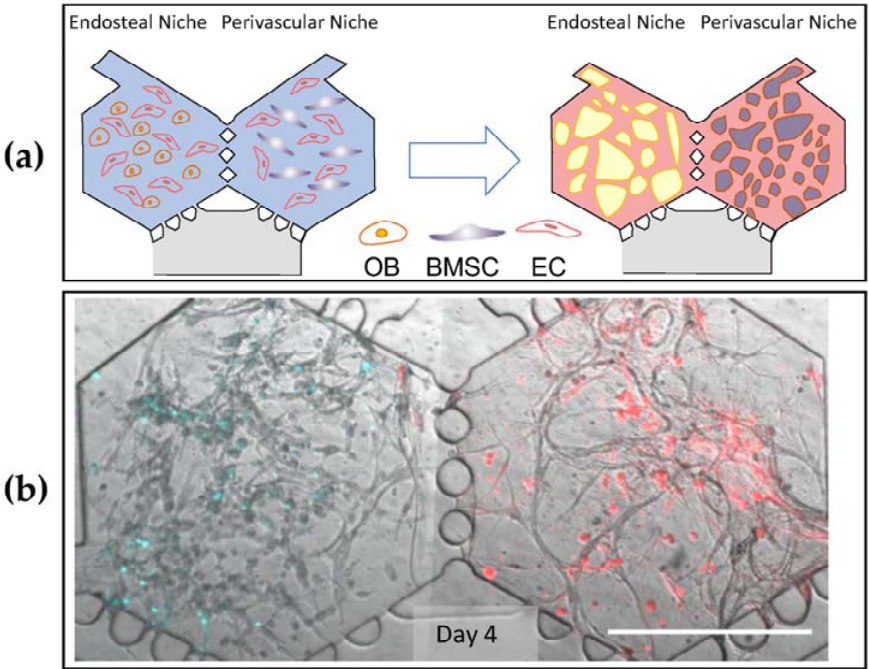
Figure 7. ( a ) Bone-on-chip schematic representation. Cord blood-derived endothelial cells (EC) seeded with either hFOB (OB, Endosteal Niche) or BMSC (Perivascular Niche) form microvascular networks in a period of 4–7 days [144], Copyright 2022, Biomaterials. ( b ) BMoaC cultured with CellTracker™ Violet hFOB and Deep Red BMSC demonstrated stromal separation by niche [144], Copyright 2022, Biomaterials.